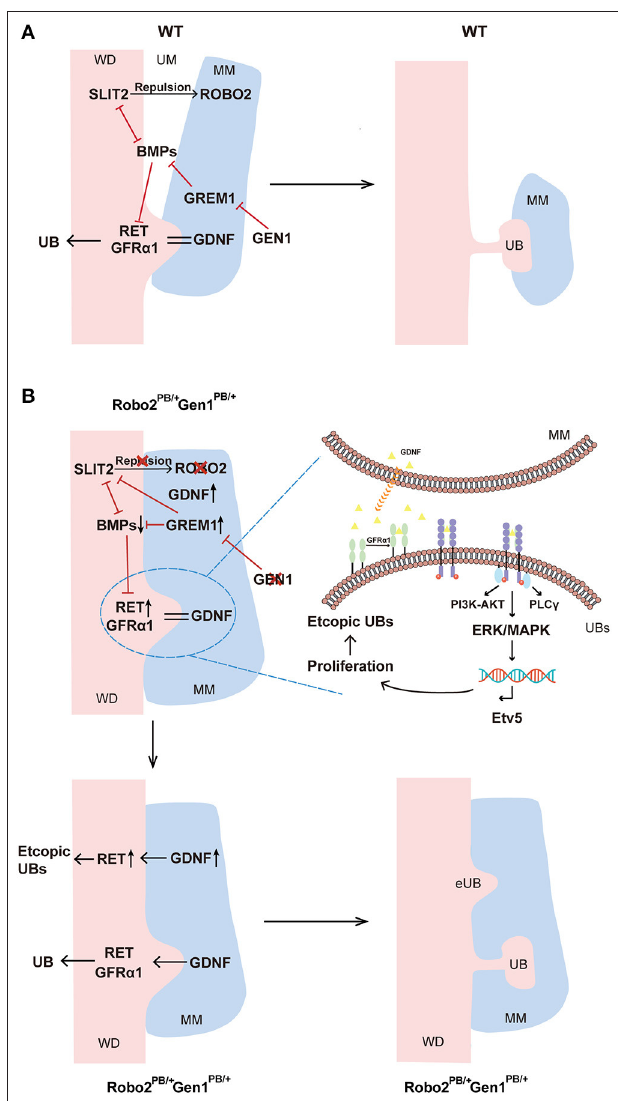
FIGURE 5 | Molecular regulation of ureteric budding and branching morphogenesis. (A) In wild-type mice, GEN1 may inhibit GREM1 expression, and GREM1 counteracts BMP signaling. Additionally, direct negative cross-talk is observed between SLIT2 and BMP2-Gremlin signaling. BMP2, BMP4 and ROBO2 inhibit GDNF signal transduction, inhibiting budding and subsequent branching of the ureter via RET and GFR α 1, thereby restricting kidney induction to the appropriate site. (B) In Robo2 PB / + Gen1 PB / + mice, decreased GEN1 expression led to increased GREM1 expression, and the high local concentration of GREM1 competitively inhibited ROBO2, reducing the binding between ROBO2 and SLIT2. Prior to UB induction, the nephrogenic cord itself is expanded due to the reduced repulsion between ROBO2 and SLIT2 relative to wild-type. In contrast, the increase in Grem1 expression exerted an enhanced inhibitory effect on the BMP signaling pathway, which may lead to the decreased inhibitory effect of BMP2 and BMP4 on RET in the WD. At the molecular level, RET is activated and recruited by GFR α 1 and GDNF and subsequently activates downstream MAPK/ERK signaling and cell proliferation. As RET transcription factor, Etv5 reflects the activation of MAPK/ERK signaling, driving ectopic UB induction in more anterior metanephric/caudal mesonephric regions. Gen1 and Robo2 may exert a synergistic effect on activating the GDNF/RET pathway. WD, Wolffian duct; MM, metanephric mesenchyme; UM, ureteric mesenchyme; UB, ureteric bud; BMPs, BMP2 and